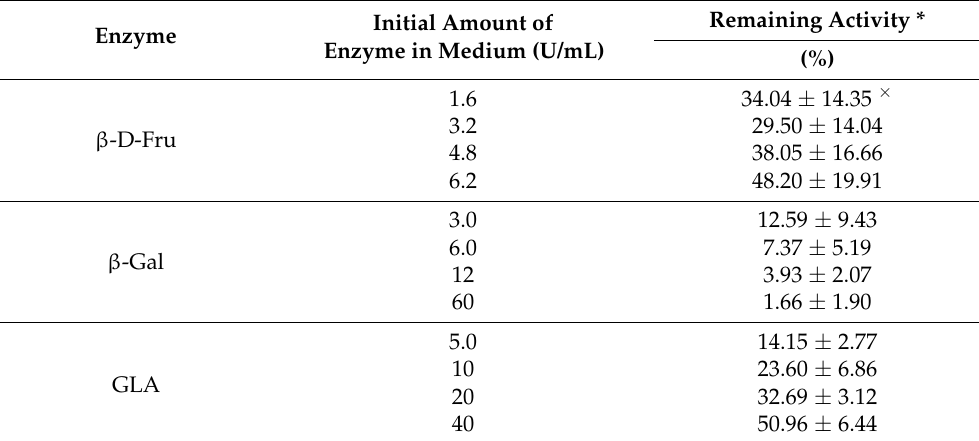
Table 1. The influence of culture conditions on analysed enzymes